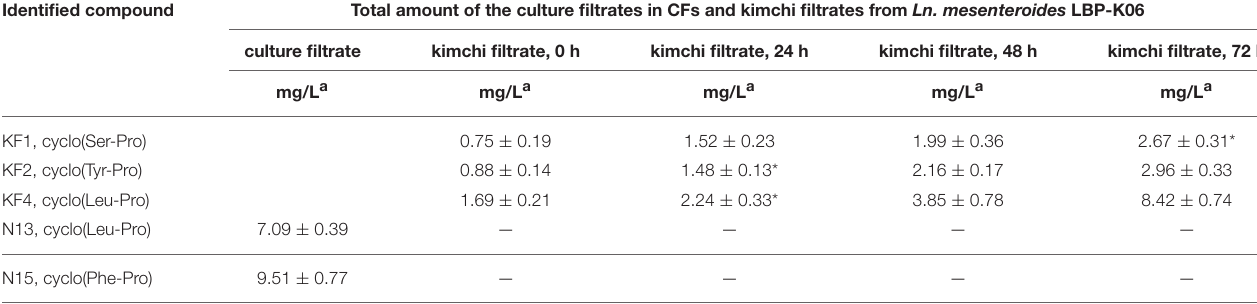
TABLE 6 | Changes in total amounts of CDPs in kimchi filtrates measured by semi-prep HPLC followed by MC extraction. Identified compound